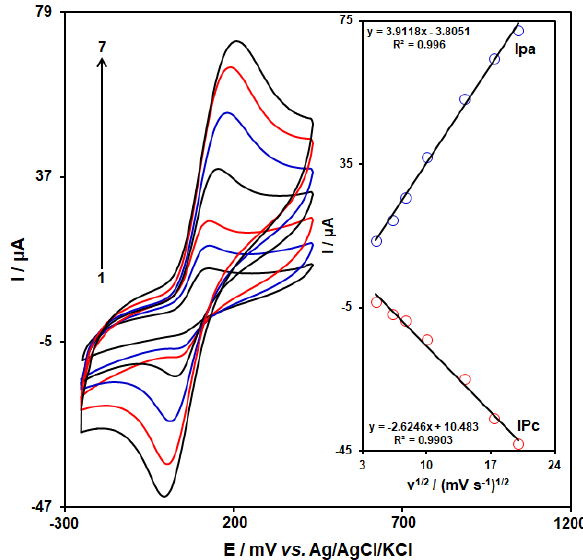
Figure 7. Cyclic voltammograms of CoMOF-GO/1-M,3-BB/CPE in 0.1 M PBS (pH 7.0) containing 250.0 µ M DA at various scan rates; 1–7 correspond to 20, 40, 60, 100, 200, 300, and 400 mV · s –1 , respectively. Inset: variation of anodic and cathodic peak currents vs. v 1/2 for electrooxidation of 250.0 µ M DA.